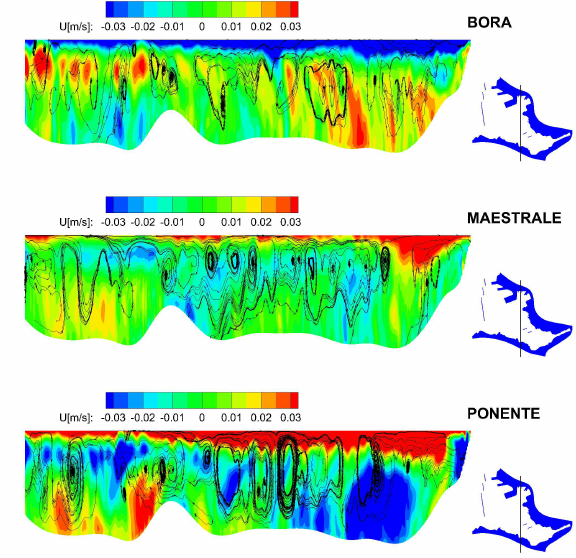
Fig. 18. Contour plots of the west–east mean velocity component, averaged on a time of 3h, in the vertical cut indicated in the small picture on the right. Solid lines represent the density anomaly. From top to bottom the plots refer to the Bora, Maestrale and Ponente scenarios. The vertical direction is magnified by a factor 100. Table 4. Residence time of the two bay zones considered.